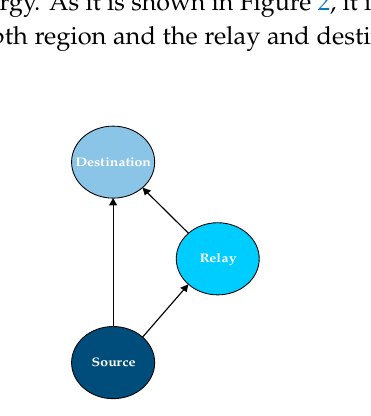
Figure 2. The position of nodes in the underwater network .